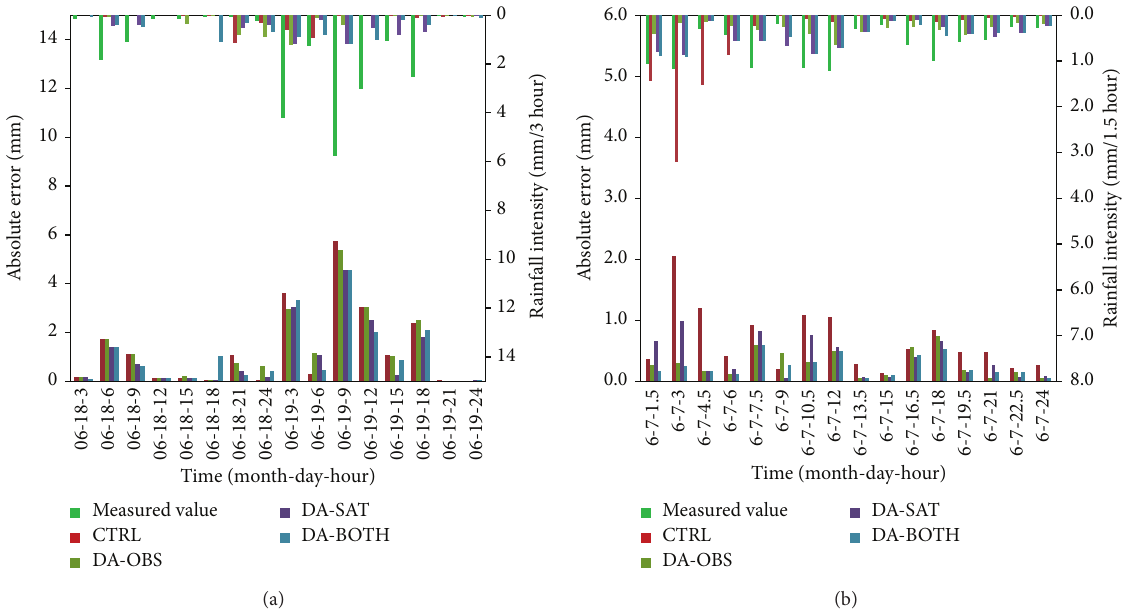
(a) Event A; (b) Event